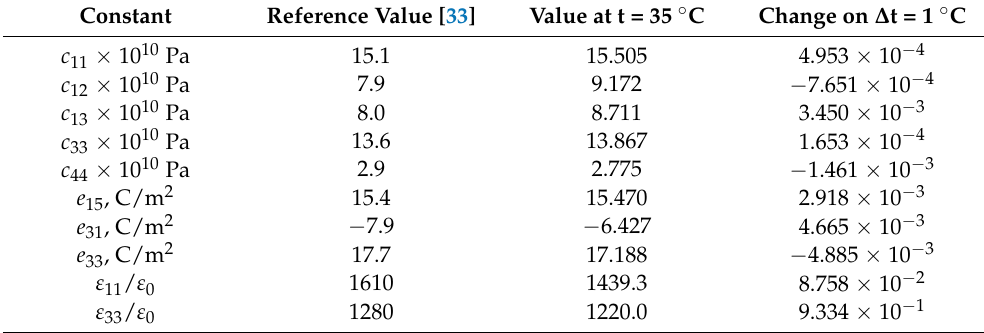
Table 2. Temperature dependencies of material constants for a sample of BPZT piezoceramics.